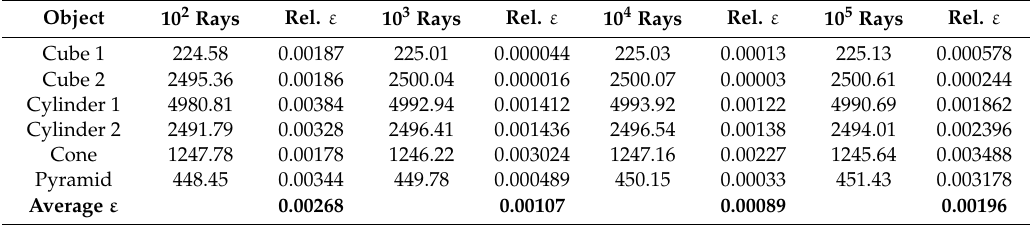
Table 3. Area estimates (cm 2 ) for di ff erent numbers of rays and relative error